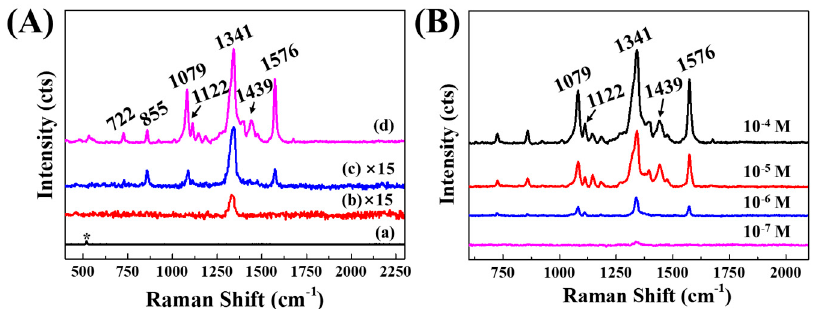
Figure 7. Raman spectra of ( A ) 4-NTP (10 − 4 mol/L) on ( a ) bare Si wafer, ( b ) Ag@LDO400, ( c ) Ag@LDO500, and ( d ) Ag@LDO600, and ( B ) 4-NTP with various concentrations on Ag@LDO600. All spectra were taken using a 514 nm Ar-ion laser, ~10 µ W power, single 5 s accumulation. *: Raman signal for silicon substrate.